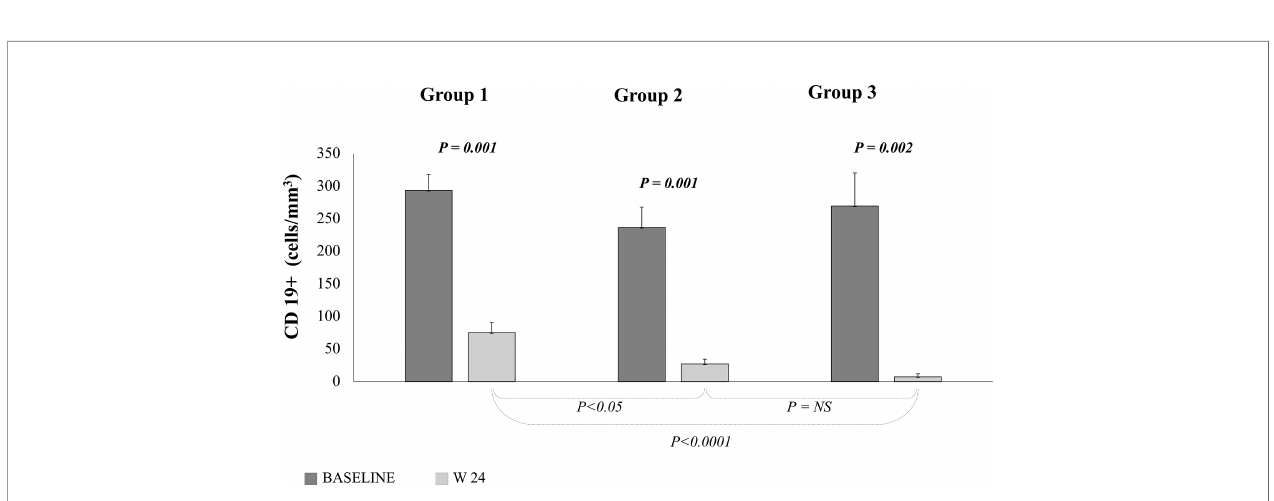
FIGURE 5 | Peripheral B cell count measured at baseline (dark grey) and 24 weeks (light grey) after treatment with different doses of RTX. Group 1 = 100 mg; Group 2 = 500 mg; Group 3 = 1000 mg x 2. Paired T test.